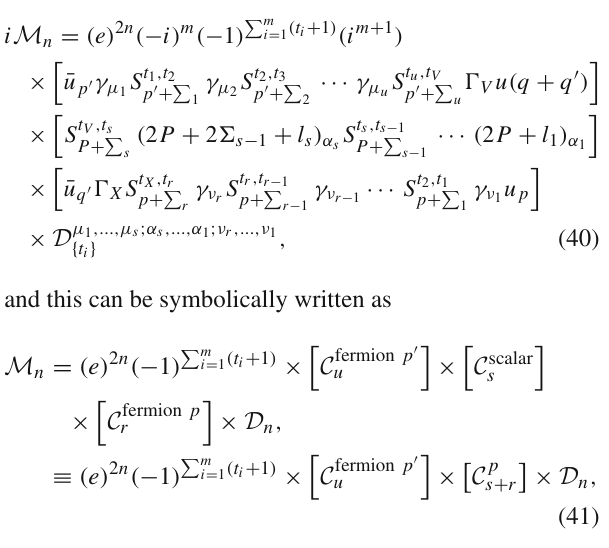
so that the momentum flowing to the right of the v th vertex on the scalar line can be expressed as ( P + (cid:16) v (cid:16) v , with v = 1 , . . . , s . There is appropriate adjustment